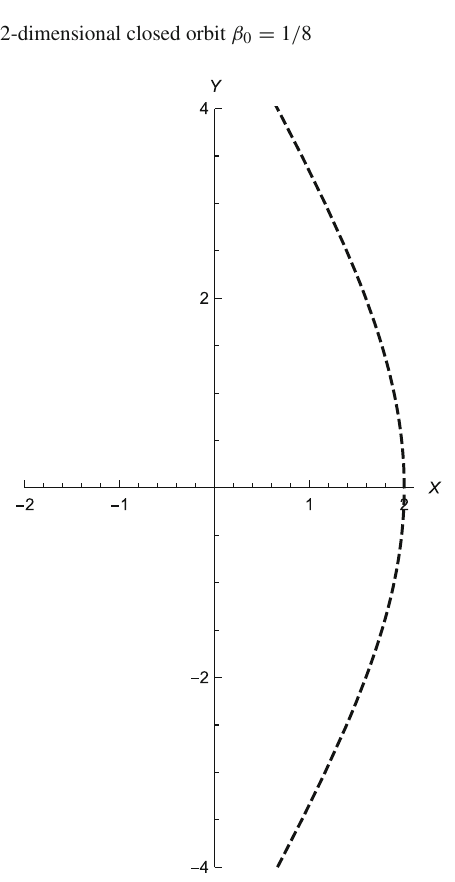
Fig. 3 2-dimensional hyperbolic orbit β 0 = 3 /